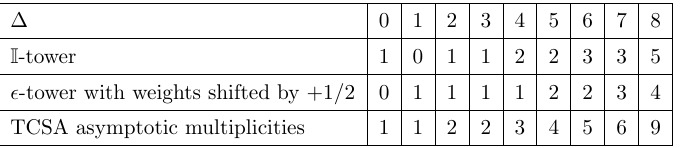
Table 6. Observed multiplicities of the large coupling (cid:12)xed point with half-integer (cid:1) max .